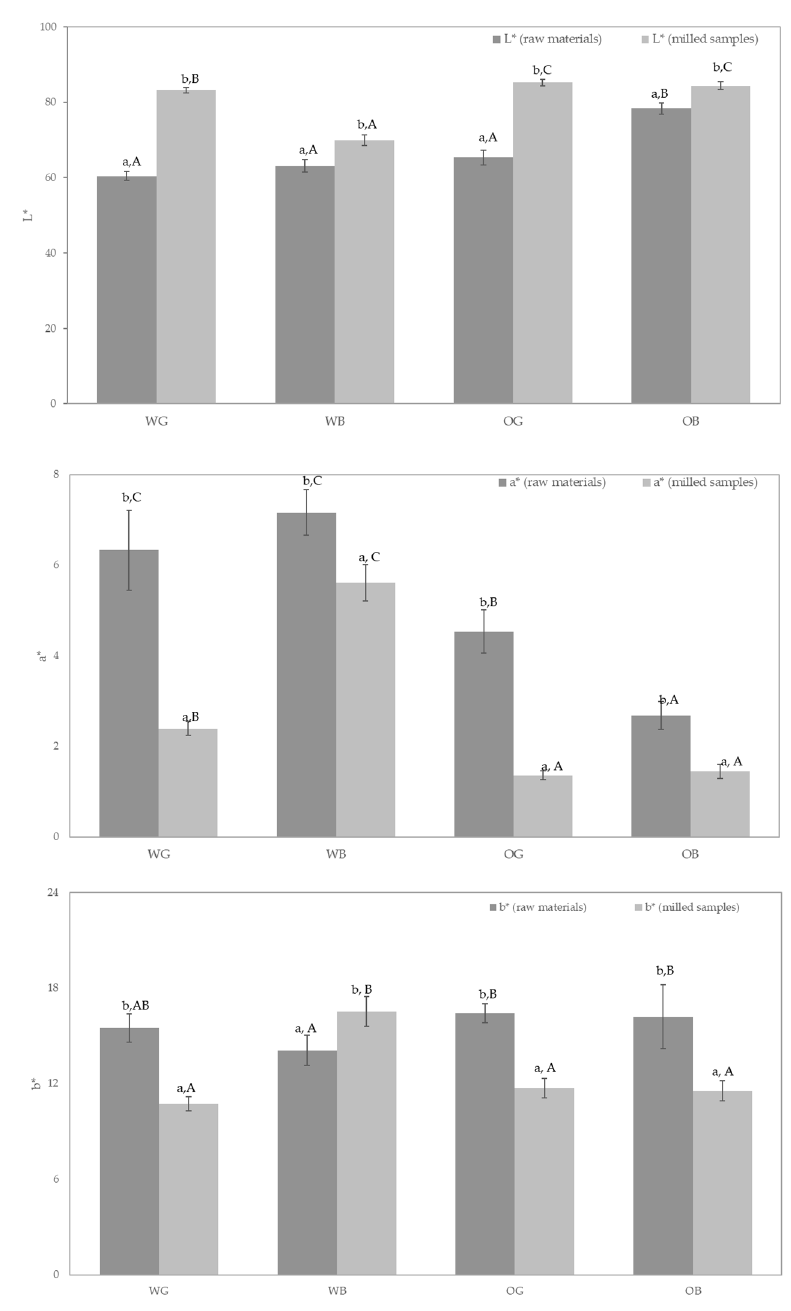
Figure 7. Colorimetric parameters (CIE L*a*b* ) of wheat grain (WG), oat grain (OG), and their brans weight bran (WB) and oat bran (OB), as raw materials (dark grey) and milled flours (clear grey). Different lowercase letters indicate significant differences ( p < 0.05) in a given sample (WG, WB, OG or OB) among raw or milled material and capital letters indicate significant differences ( p < 0.05) in a given material (raw or milled) among samples (WG, WB, OG, and OB).